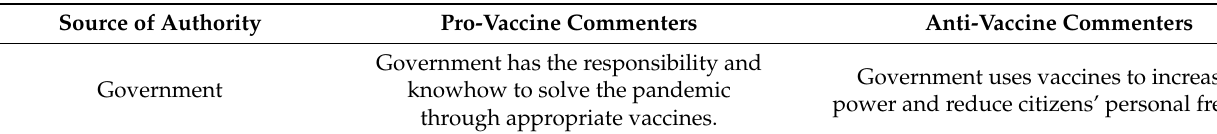
Table 1. Sources of authority in pro- and anti-vaccine